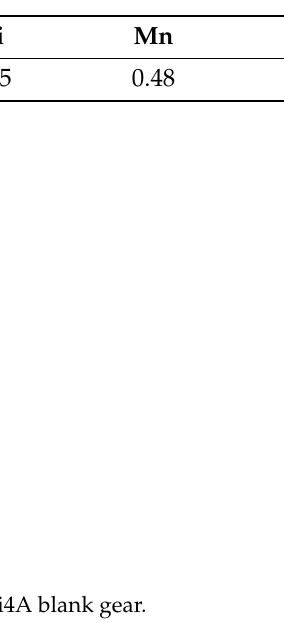
Table 1. Chemical compositions of 20Cr2Ni4A steel (wt.%).